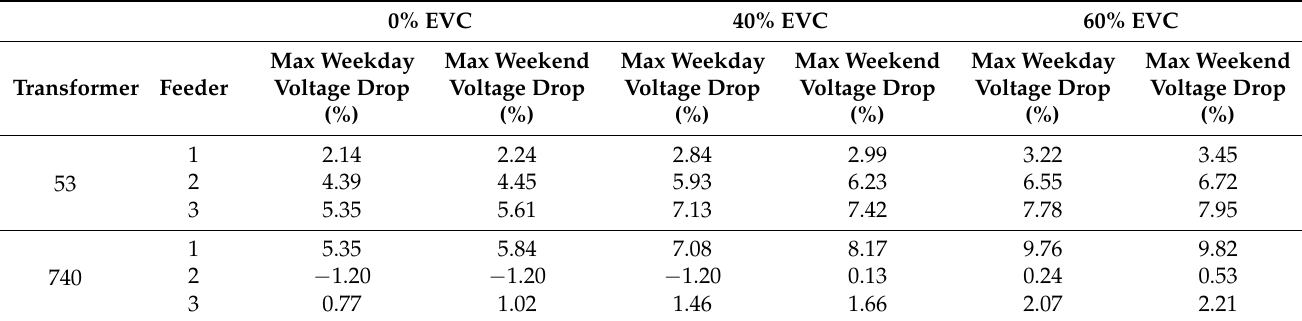
The voltage drop with 0% is within the acceptable range (i.e., 5%). Transformer 53, Feeder 3 and Transformer 740, Feeder 1 with 0% EVC have the lowest voltage, while Transformer 740, Feeder 2 and Transformer 53, Feeder 1 have the highest voltage. Voltage drop for Feeders 1, 2, and 3 of each transformer changed after adding 40% and 60% EVC to the LV feeders, as shown in Table 6. Table 6. Voltage drop of the LV network during summer with 0%, 40% and 60% EVC. 0% EVC